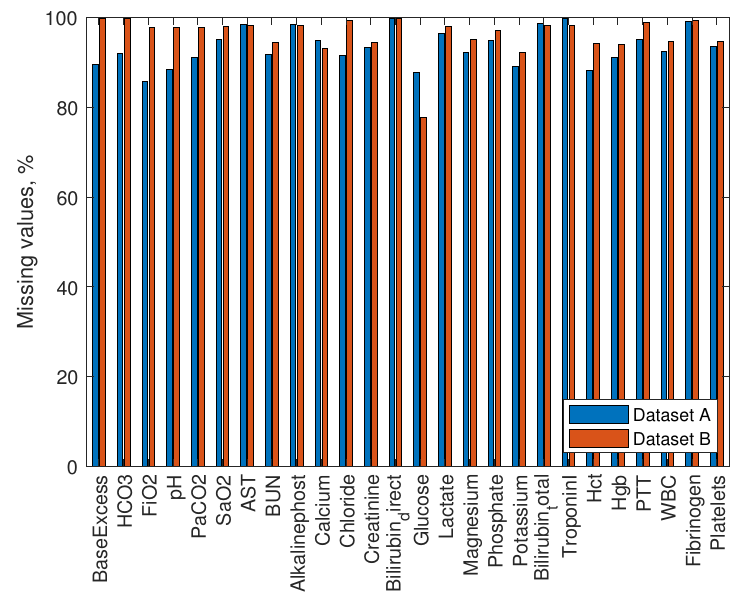
Figure 2. Missing laboratory values in the